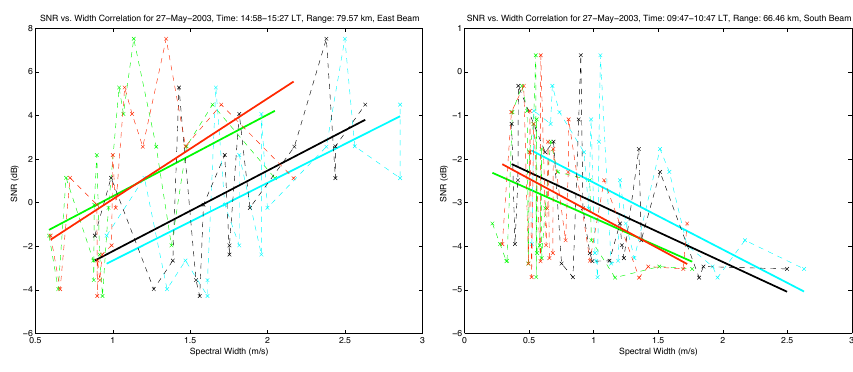
Fig. 3. Examples of positive and negative correlation between SNR and spectral width. The green and red data points indicate spectral widths obtained from logarithmic fitting of spectral models (4) and (5), respectively. The cyan data points are spectral widths obtained from the correlation times, and the black data points are widths obtained from the correlation times with the triangular weighting function taken into account. The solid lines indicate linear fits to their associated data points.